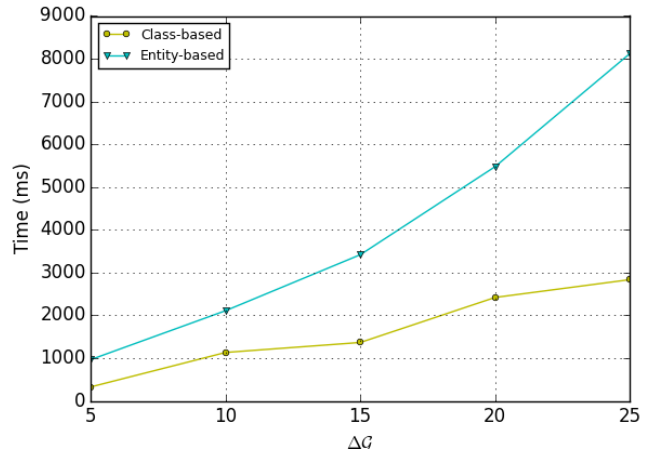
Figure 13. Computation time with different amounts of